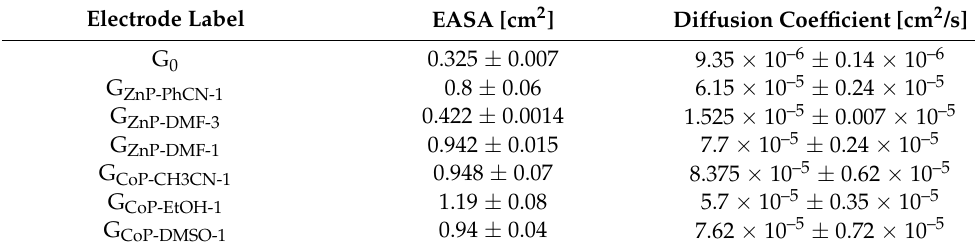
Table 2. The calculated EASA and diffusion coefficient